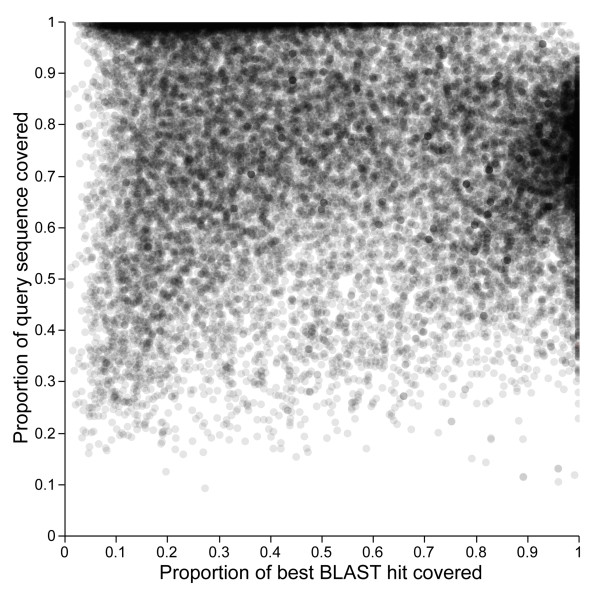
Proportion of each of the assembled sequences that is aligned to its top BLASTx protein hit versus the proportion of the top hit which is covered by the assembled query sequence. This plot demonstrates the size of our assembled transcripts relative to their homologs in other plant species. Dense clusters of points along the top of the figure represent loci entirely aligned to their respective protein hits and points along the right are genes fully covering their best BLAST protein hit.